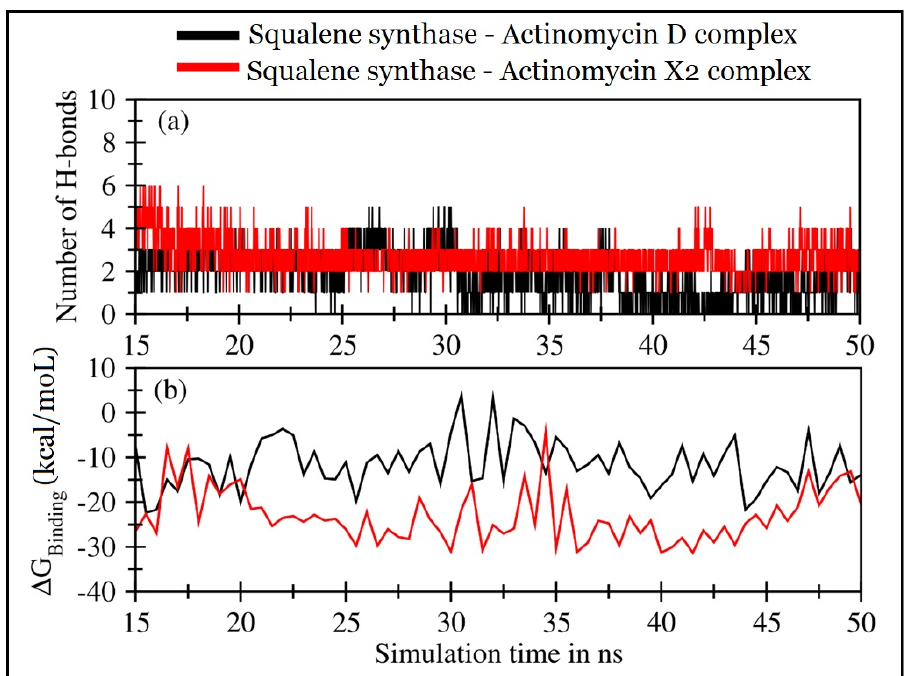
Figure 9. Trajectory analyses for the squalene synthase complexed with actinomycins D (black lines) and X 2 (red lines): ( a ) number of hydrogen-bonds formed between the protein and the actinomycins D (mean: 2.02 ± 1.10) and X 2 (mean: 2.99 ± 1.04), and ( b ) molecular mechanistic Poisson–Boltzmann surface area protein–ligand binding energy calculated after every 0.5 ns.